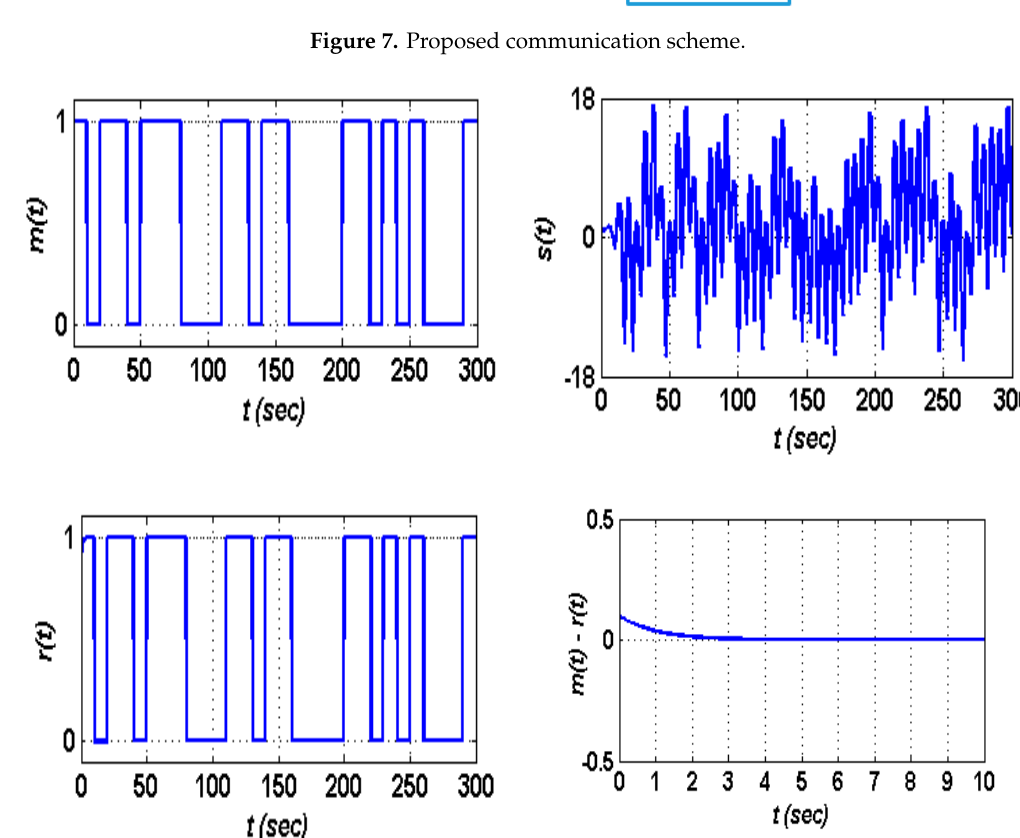
Figure 8 . Signals of the proposed secure communication scheme. Figure 8. Signals of the proposed secure communication